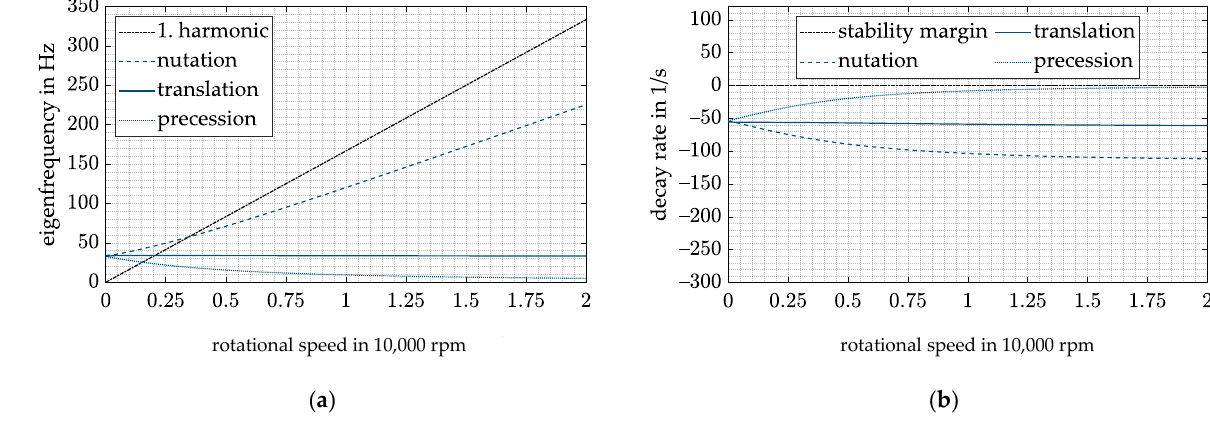
Figure 9. ( a ) Campbell diagram with DVFC; ( b ) decay rate with DVFC.